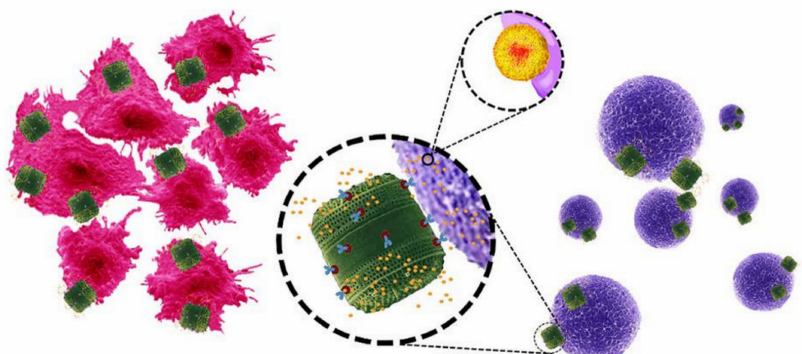
Figure 13. Genetically engineered diatom biosilica (green) containing liposome-encapsulated drug molecules (yellow) can be targeted to both adherent neuroblastoma cells (red) and lymphocyte cells in suspension (purple) by functionalizing the biosilica surface with cell-specific antibodies. Liposome-encapsulated drug molecules are released from the biosilica carrier in the immediate vicinity of the target cells (inset). Reprinted from [70], copyright (2015), with permission from Springer